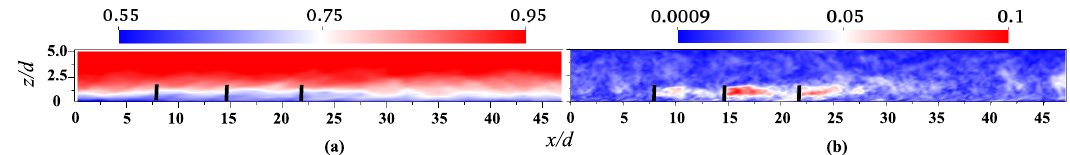
u for spanwise wavenumbers, (cid:107) (cid:107)